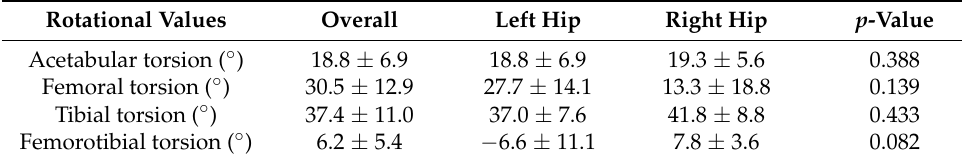
Table 2. Rotational alignment of the lower extremity before